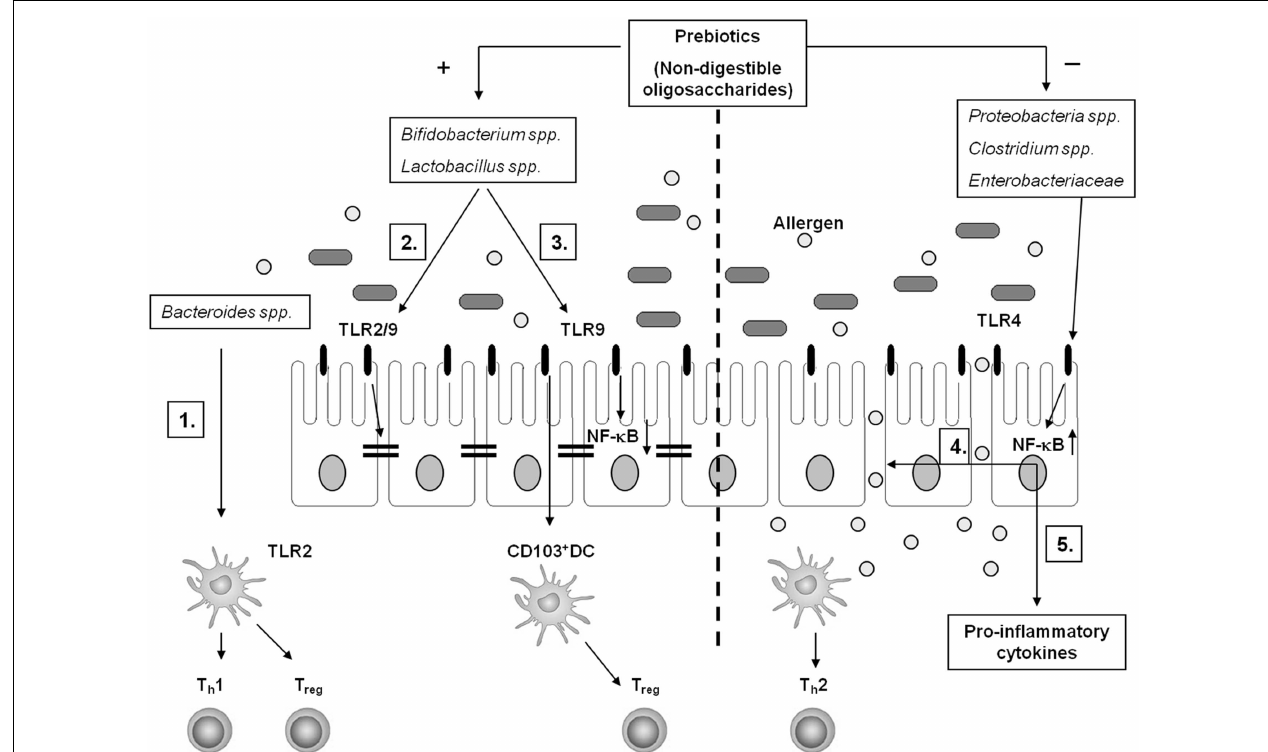
NF- κ B activation (3). In food allergy, the microbiota composition shifts toward a higher frequency in Proteobacteria spp., Clostridium spp.,